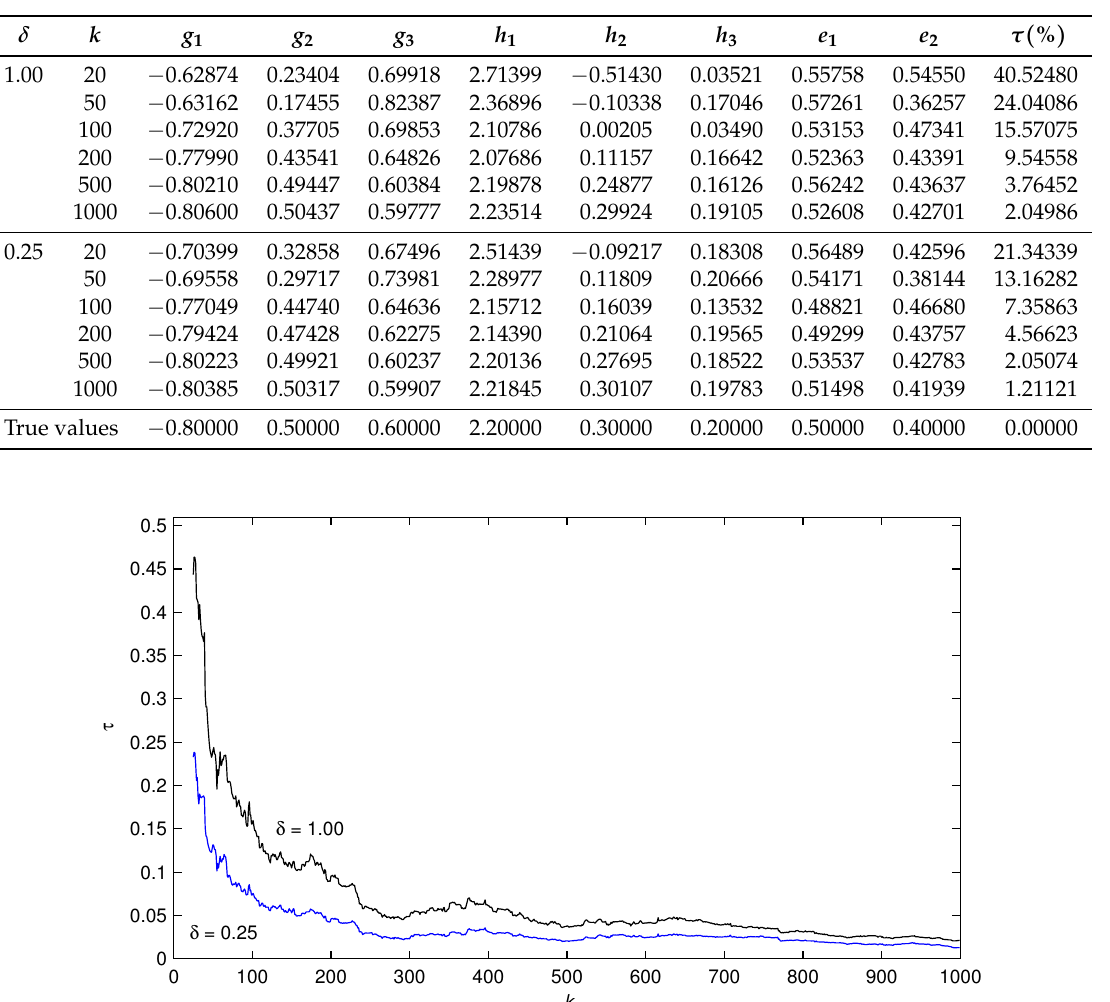
Table 3. The bias compensation-based parameter estimates and errors for Example 2.